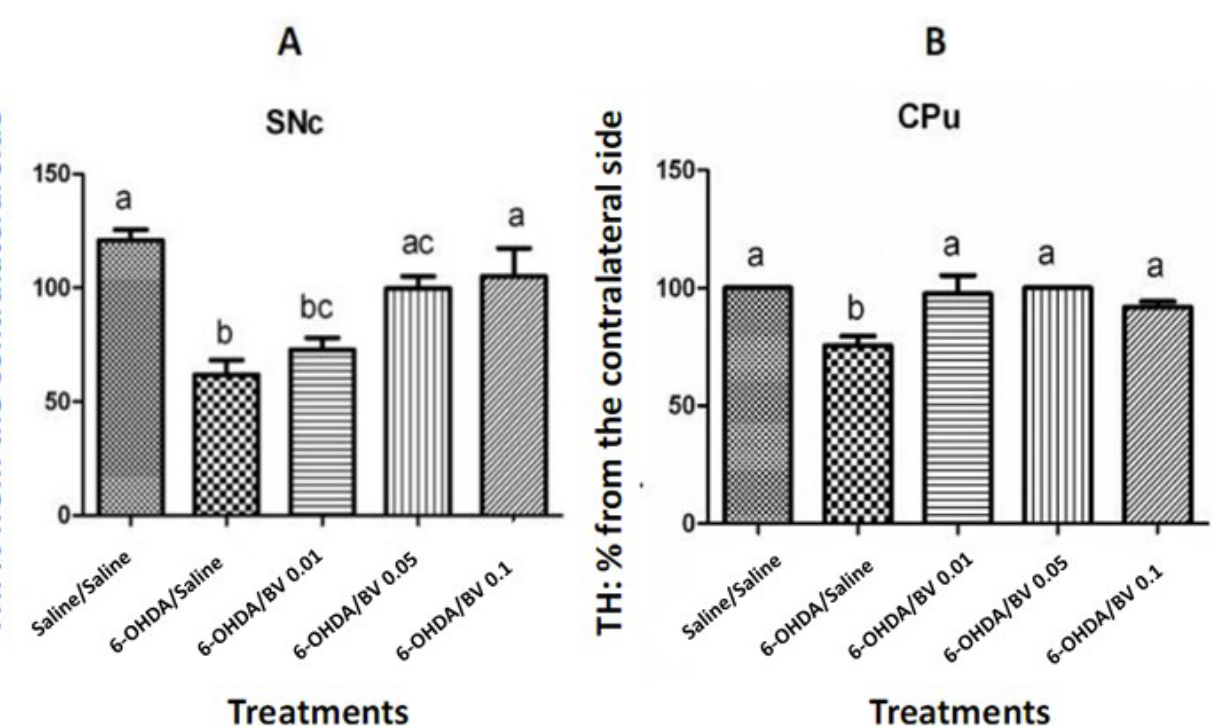
Figure 7. Percentages of tyrosine-hydroxylase-positive cell density (TH + ) in the: ( A ) substantia nigra pars compacta (SNc) and ( B ) striatum (CPu). Different letters indicate statistical difference between groups in SNc ( p < 0.0001) and in Cpu ( p = 0.001), while equal letters indicate similar results. BV: bee venom; 6-OH: 6-hydroxydopamine. Columns represent the mean and bars represent the S.E.M. One-way ANOVA followed by Tukey’s post